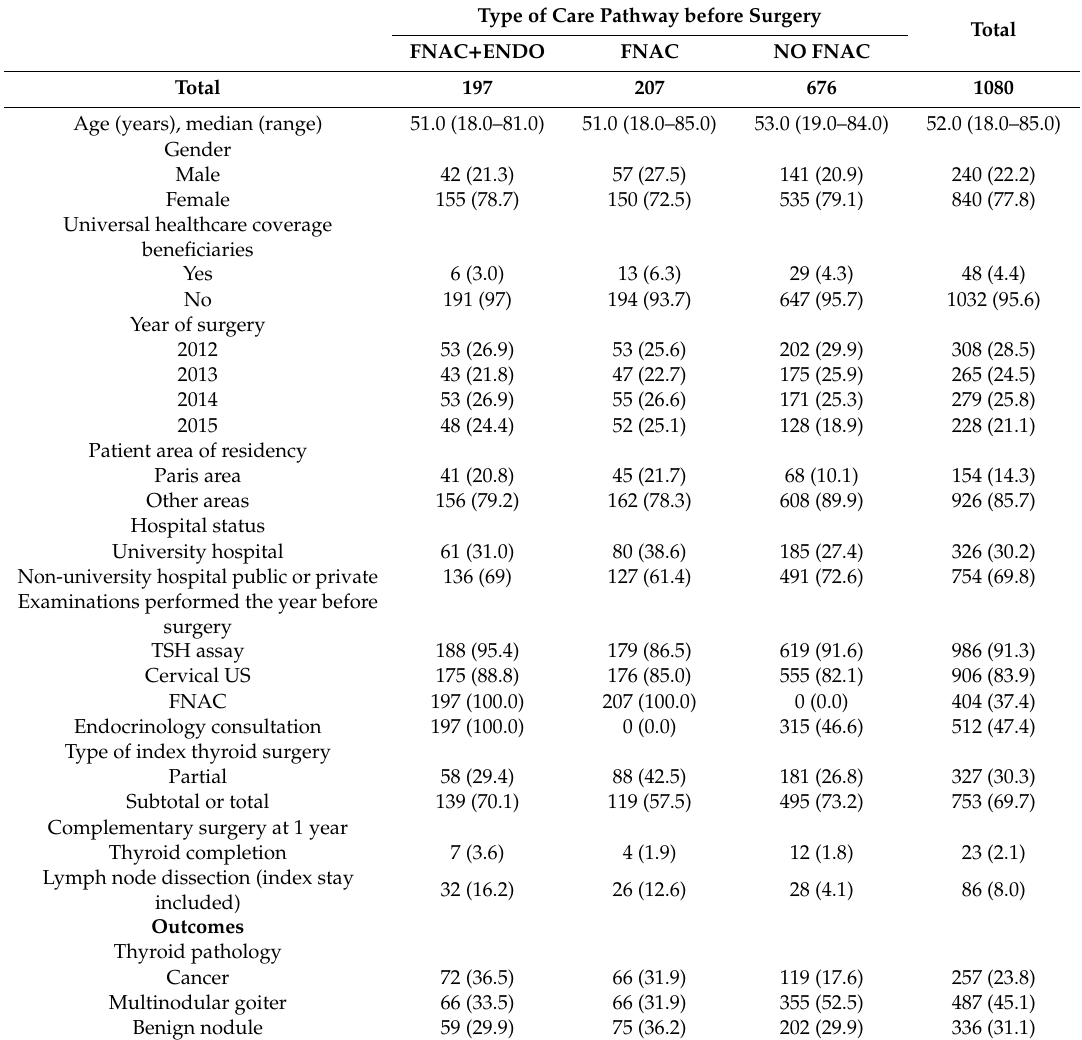
Table 1. Characteristics of the 1080 patients who underwent thyroid nodule surgery between 2012 and 2015 according to their distribution in the 3 care pathways.